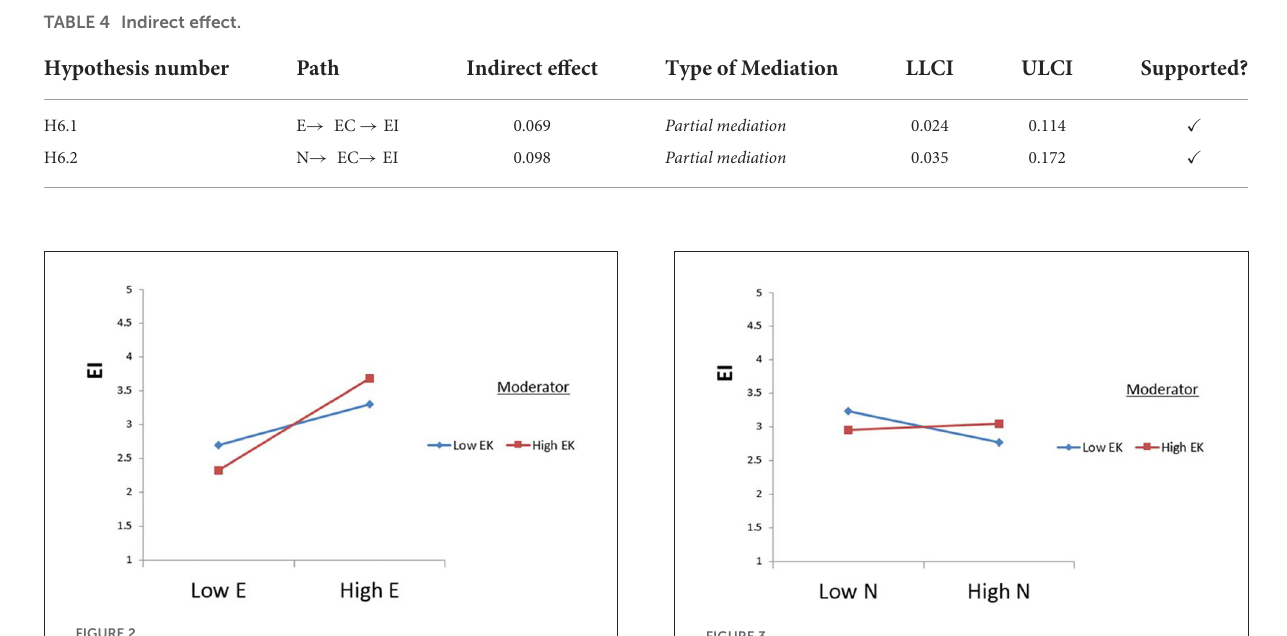
FIGURE3 Moderating effect of environmental knowledge (EK) on the relationship between neuroticism (N) and ecotourism intention (EI).